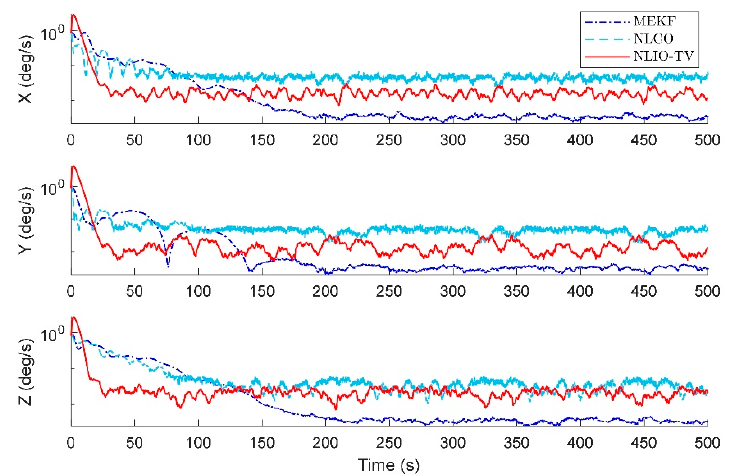
Figure 15. Averaged absolute gyro bias estimation errors over 100 simulations. Table 6. MAEs of attitude for all observers.